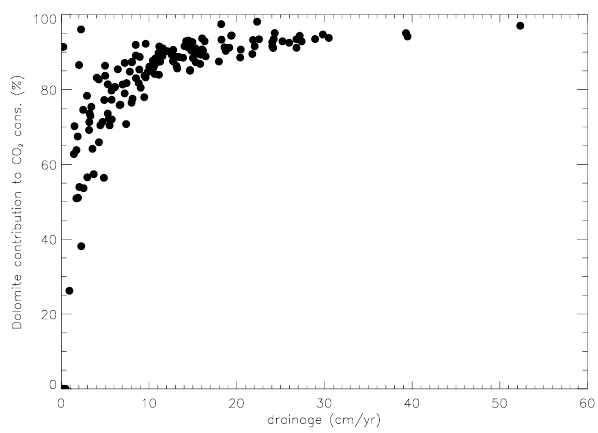
Fig. 7. Relative contribution of calculated dolomite dissolution to Figure 7 the CO 2 consumption in the north plotted as a function of vertical drainage. Each point stands for a yearly averaged